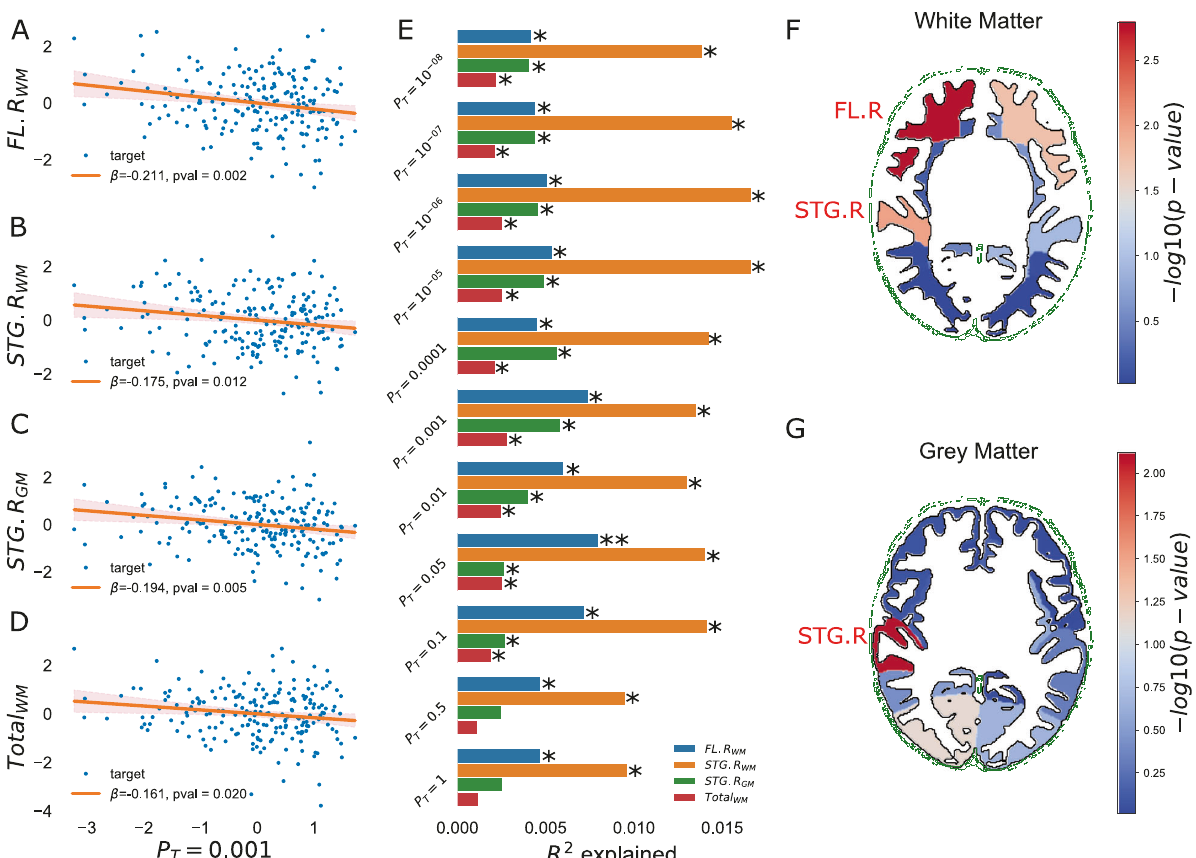
Fig. 3 Visualisation of the signi fi cant association between the schizophrenia PRS and the regions of interest in the European ancestry cohort ( n = 207). A – D Scatter plots of infant brain volume against Schizophrenia PRS at P T = 0.001. Brain volumes have been adjusted for GA, PMA, sex and ICV. PRS have been adjusted for the fi rst 3 ancestral principal components. Axes are standardised to zero mean and unit variance. The shaded area denotes the con fi dence interval ( E ): Bar plot of brain volume variance R 2 explained by PRS, calculated as the difference between the R 2 of the full model with PRS as a covariate and that of the null model without the PRS as a covariate. *nominal signi fi cant result; **result surviving multiple testing correction. F , G Visualisation of the signi fi cant associations between the PRS at P T = 0.001 and brain volumes of white ( F ) and grey matter ( G ) regions of interests. Colour bar denotes the range of – log 10 ( p -value). (FL.R- right frontal lobe, STG.R- right superior temporal